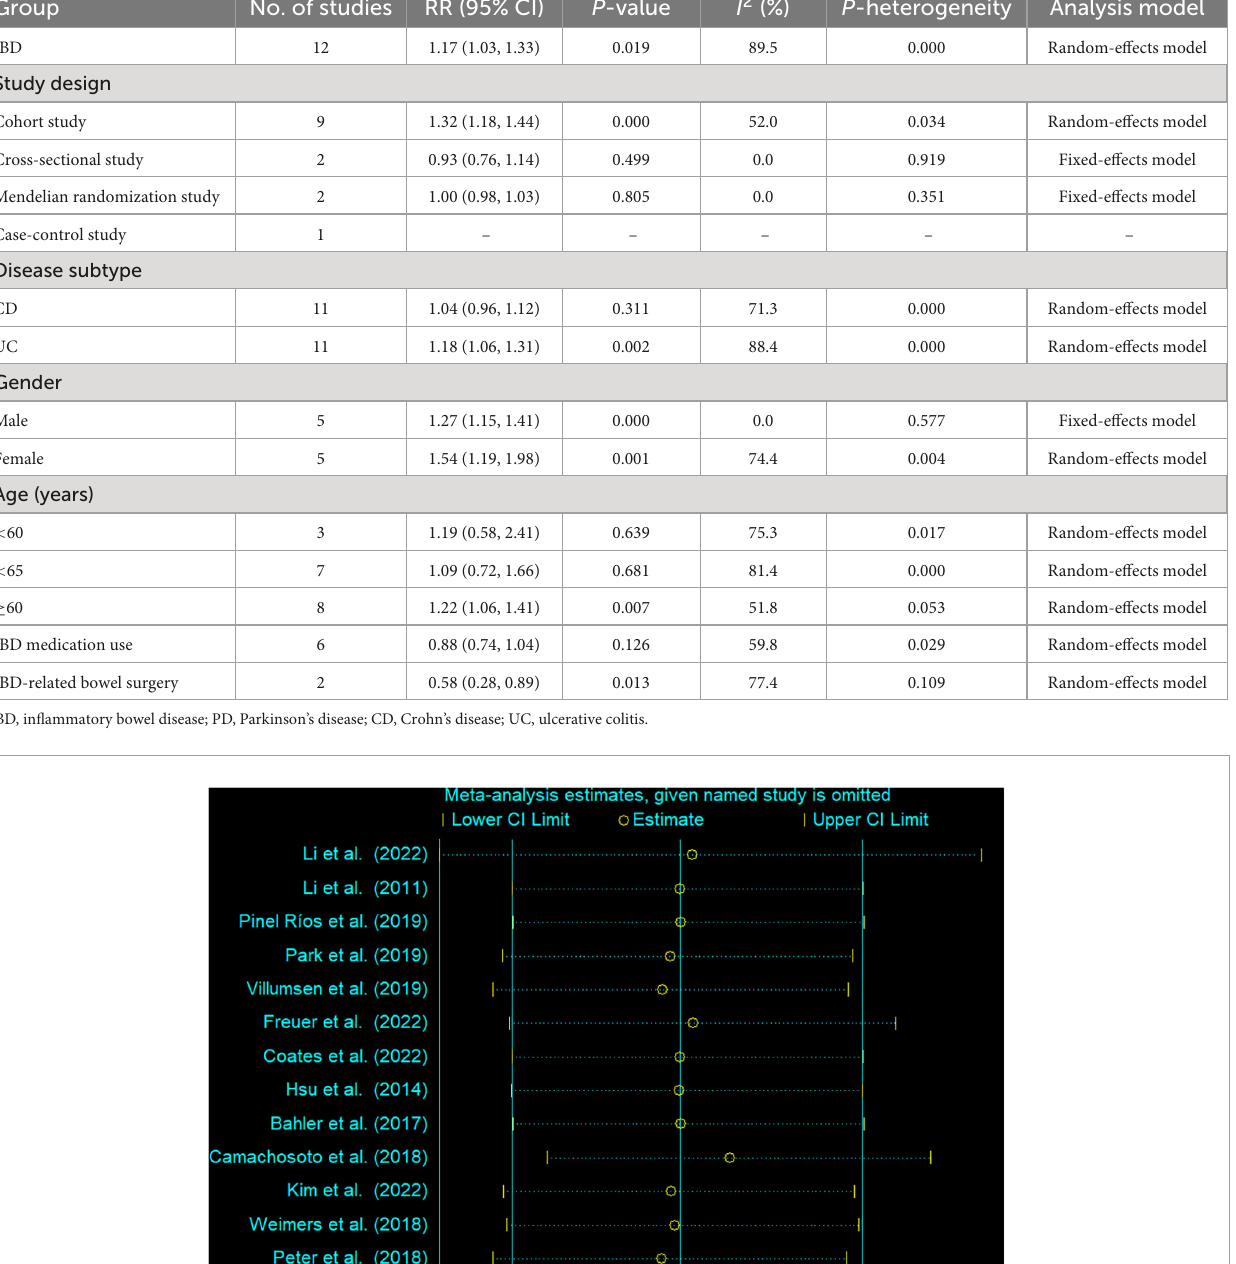
to the epidemiological survey, PD affects 1–2 per 1,000 of the population, which is rare before the age of 50 years, the incidence rate of PD in population over 60 is about 1%, and most PD patients are diagnosed from 65 to 70 years old (1). In any study, the older the baseline age, the higher the risk of PD. Our study included a large number of individuals, and the larger the number, the closer to the results of epidemiology. Although we utilized the random-effects